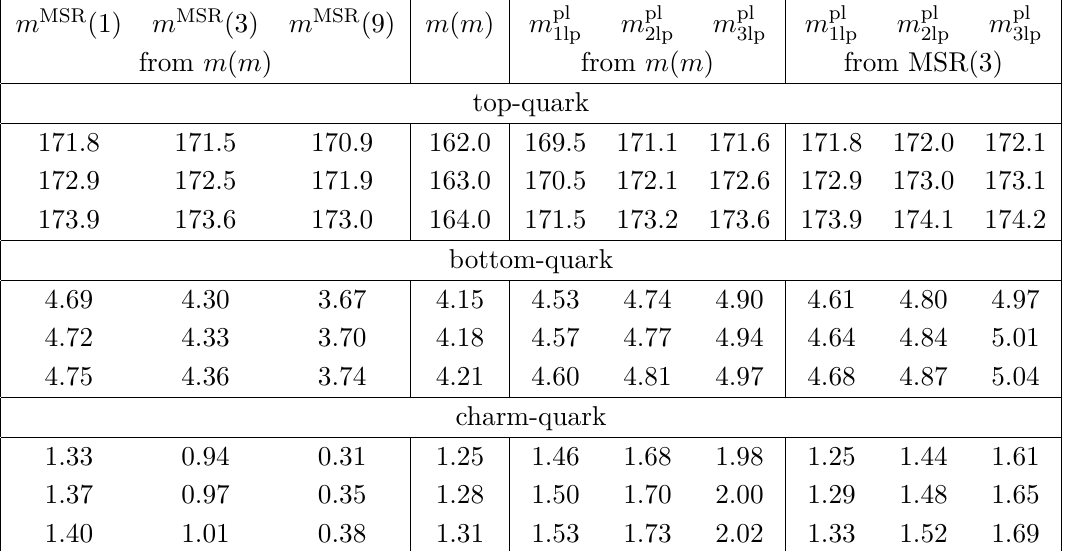
Table 1 . Numerical values for heavy-quark MSR, MS and pole masses. Columns 1–3 and 4 show the MSR masses at different R scales (1, 3 and 9 GeV) and the MS mass from which they are obtained [23, 66] using eq. (2.9) with the anomalous dimensions at three-loop for the R -evolution of the MSR mass from the scale R 0 = m ( m ) to R . Columns 5–7 show the one-, two- and three-loop pole masses obtained from the conversion of the MS mass in eq. (2.3). Columns 8–10 show